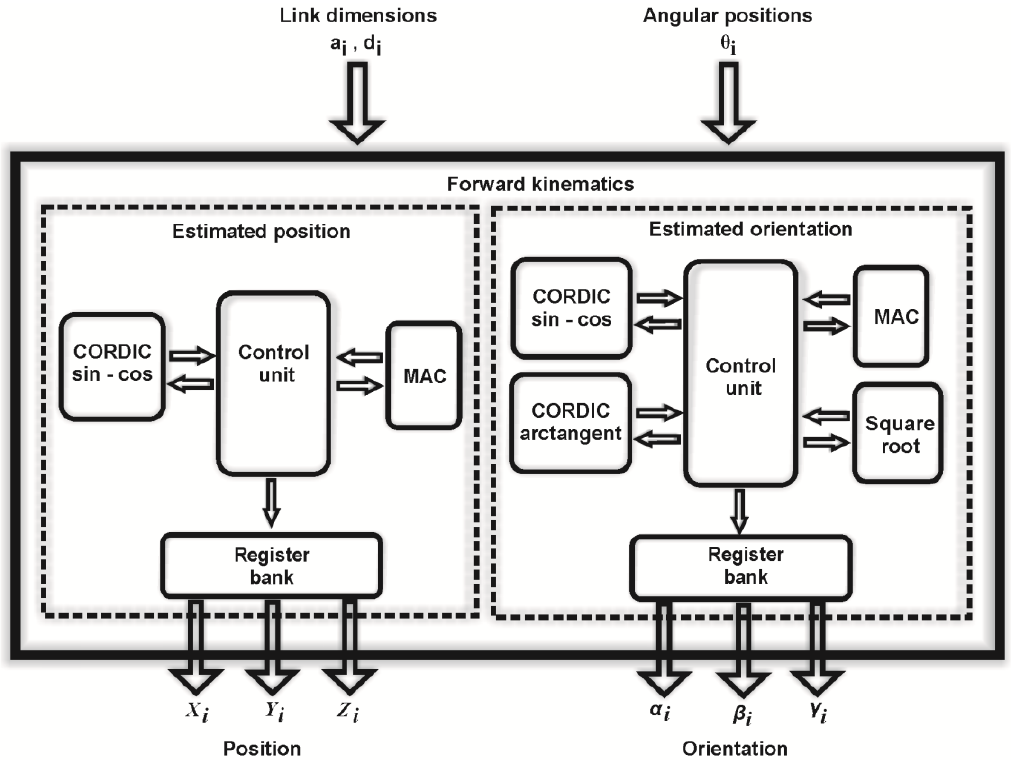
Figure 5. Forward kinematics hardware